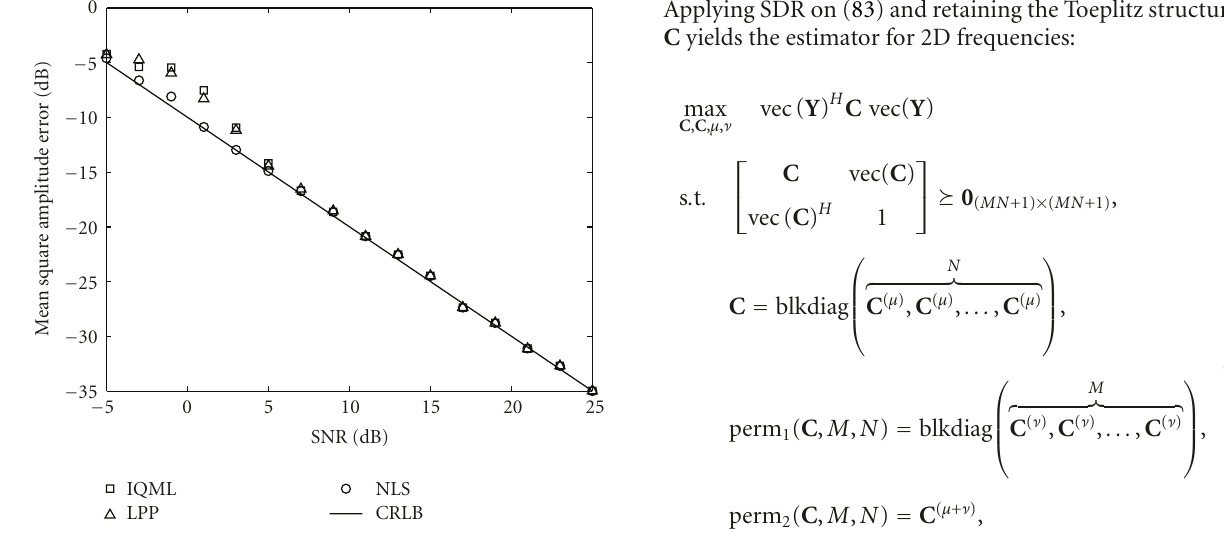
Figure 7: MSE for A of single real sinusoid with fixed φ .